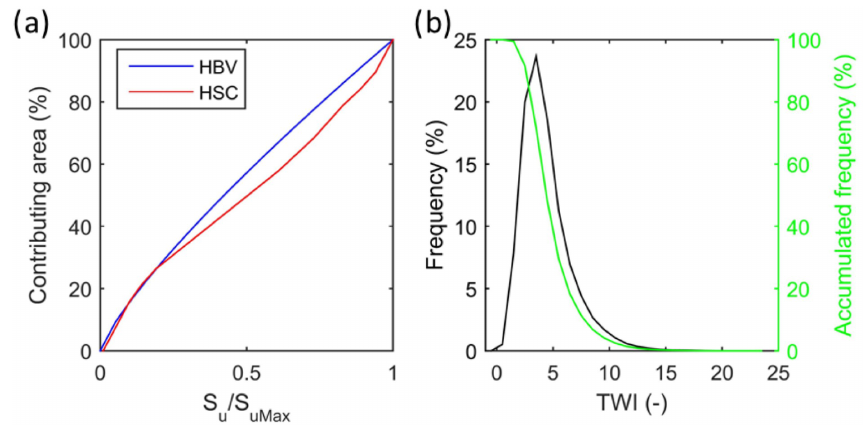
Figure 8. The curves of the beta function of the HBV model, and the S u – A s curve generated by the HSC model (a) . The frequency and accumulated frequency of the TWI in the Bruntland Burn catchment (b) .